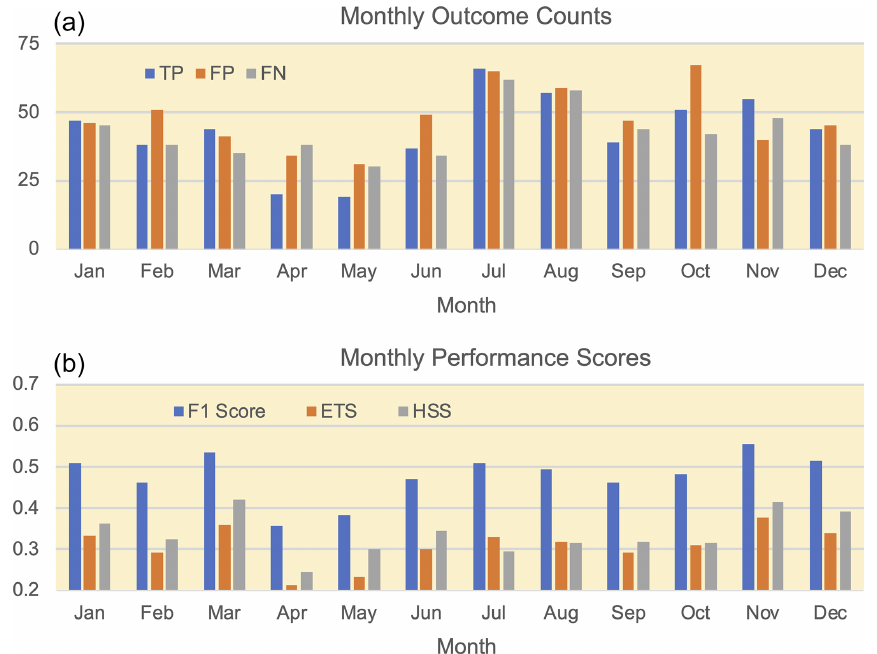
Figure 5. (a) Monthly counts of predicted TP, FP, and FN outcomes and (b) performance scores for each month. All results are taken from validation of Beijing cases with 16